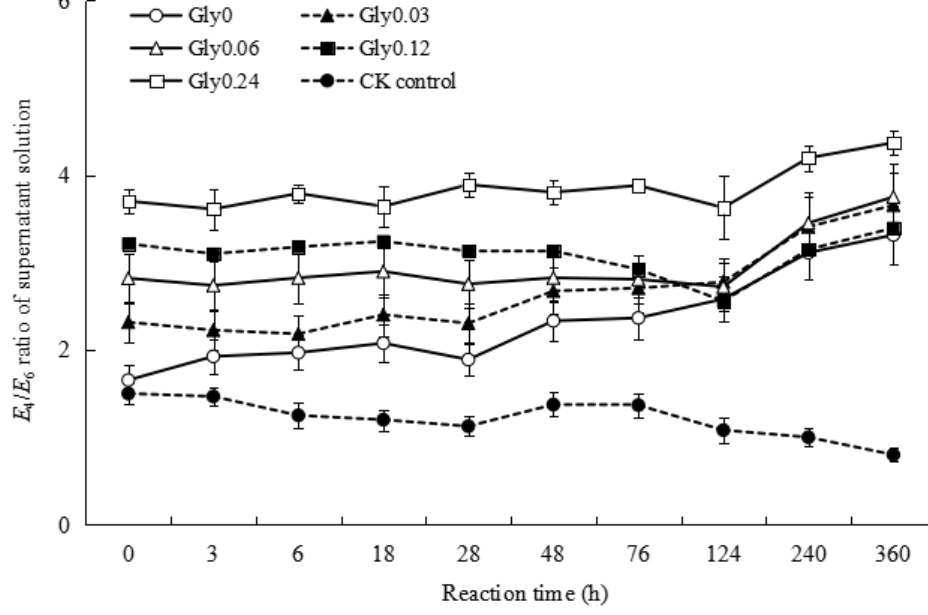
Figure 1. Effects of the glycine with different concentrations in the Maillard precursors on the E 4 / E 6 ratio of the supernatant solution. Note: The treatments added different glycine concentrations (0, 0.03, 0.06, 0.12 and 0.24 mol/L) are represented by Gly0, Gly0.03, Gly0.06, Gly0.12 and Gly0.24, respectively. The error bars in the scatter plots indicate the standard deviation for each data point. The same below.